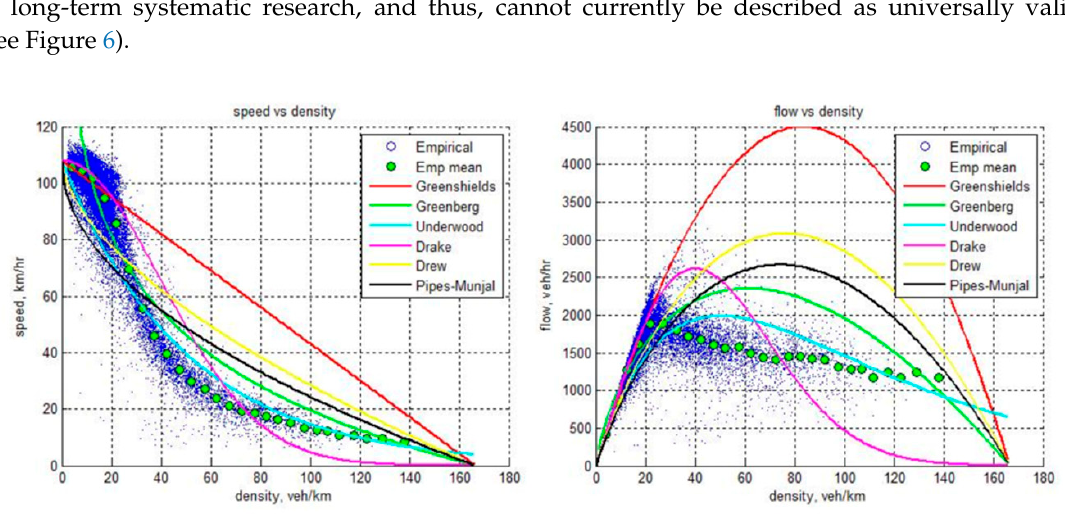
Figure 6. Basic diagrams comparing macroscopic traffic flow status model variables (Ni 2015).